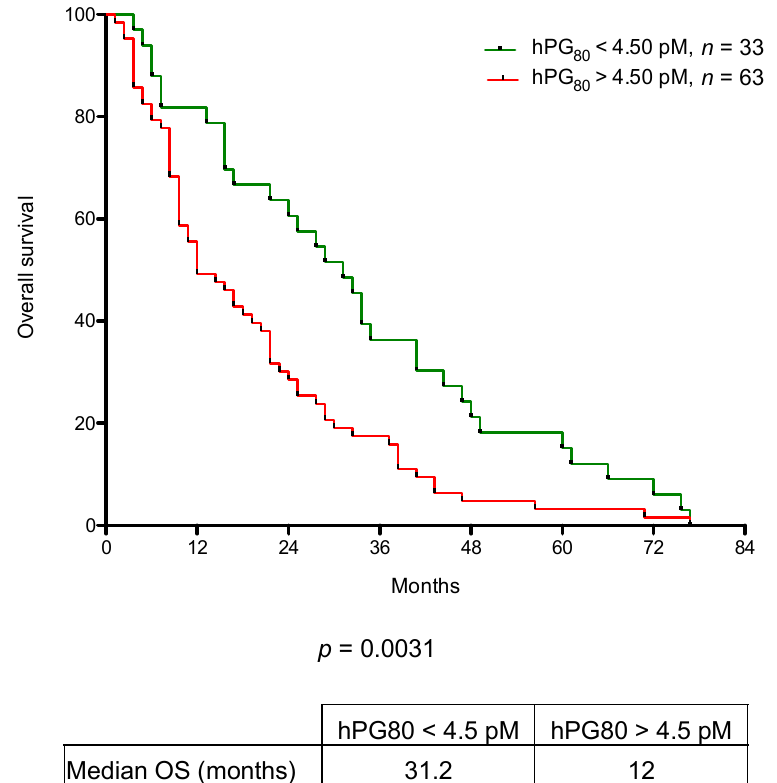
Figure 3. Overall survival according to hPG 80 levels. Kaplan-Meier analysis of OS for mRCC patients according to hPG 80 levels. The p values from the log-rank test are indicated.